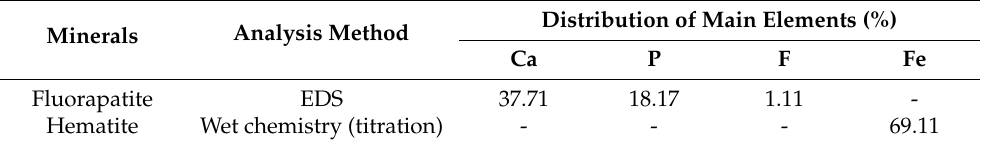
Table 1. Distribution of main elements in the used mineral